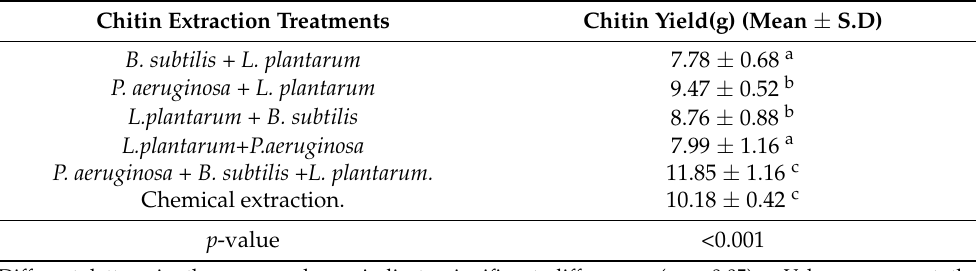
Table 1. Mean chitin yield (g) from biological and chemical extraction from the black soldier fly pupal